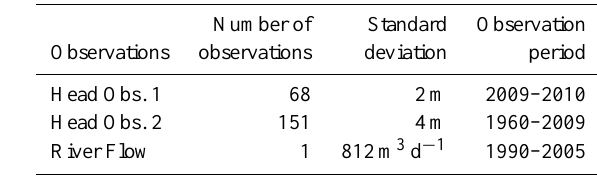
Table 1. Observations of groundwater head and river